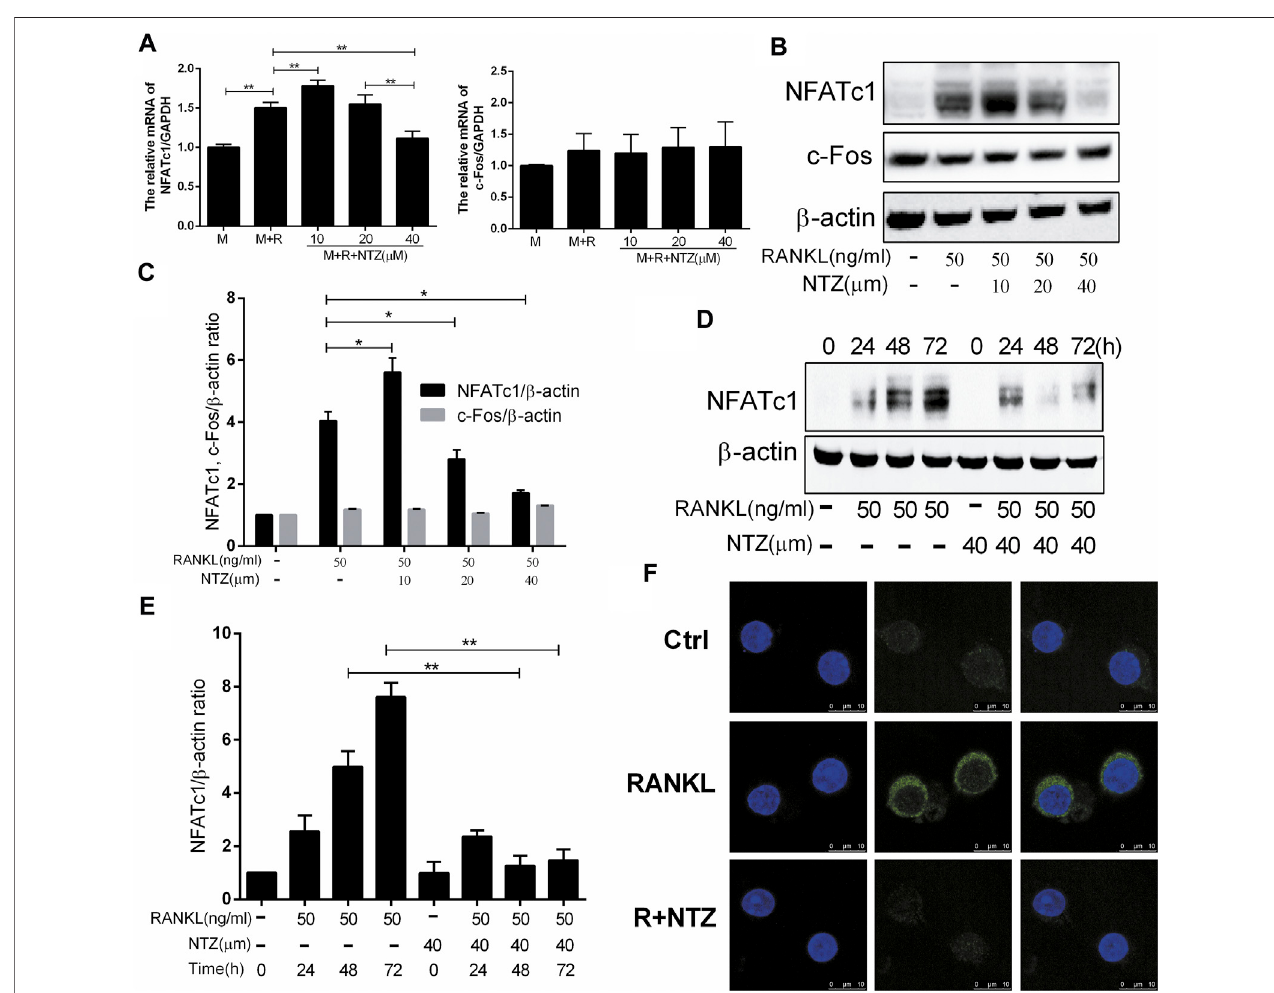
FIGURE 6 | Nitazoxanide suppressed RANKL-induced NFATc1 expression. (A) BMMs were treated with various concentrations of NTZ, M-CSF (10 ng/ml), and RANKL (50 ng/ml) for 3 days. NFATc1 and c-Fos expression was determined by real-time PCR. (B) RAW264.7 cells were pretreated with the indicated NTZ doses for 2 h,andRANKLwassubsequentlyaddedfor3 days.ExpressionofNFATc1andc-Foswasdetectedbywesternblotting. β -actinwasusedasaloadingcontrol. (C) The relativeratiosofNFATc1 and c-Fosto β -actin werequanti fi ed byImageJ. (D) RAW264.7 cellswerepretreated with40 µM NTZfor2 h, then RANKLwasadded for the indicated time. Cell lysates was used to analyzed the expression of NFATc1. β -actin was used as a loading control. (E) The quantitative analysis of NFATc1/ β -actin expression was performed by ImageJ (F) Cells were treated as in (B) , NFATc1 expression was analyzed using immuno fl uorescence. Error bars represent mean ± SD from three independent experiments. ctrl (cid:2) control; M (cid:2) M-CSF; NTZ (cid:2) nitazoxanide; R (cid:2) RANKL. * p value ＜ 0.05, ** p value ＜ 0.01.